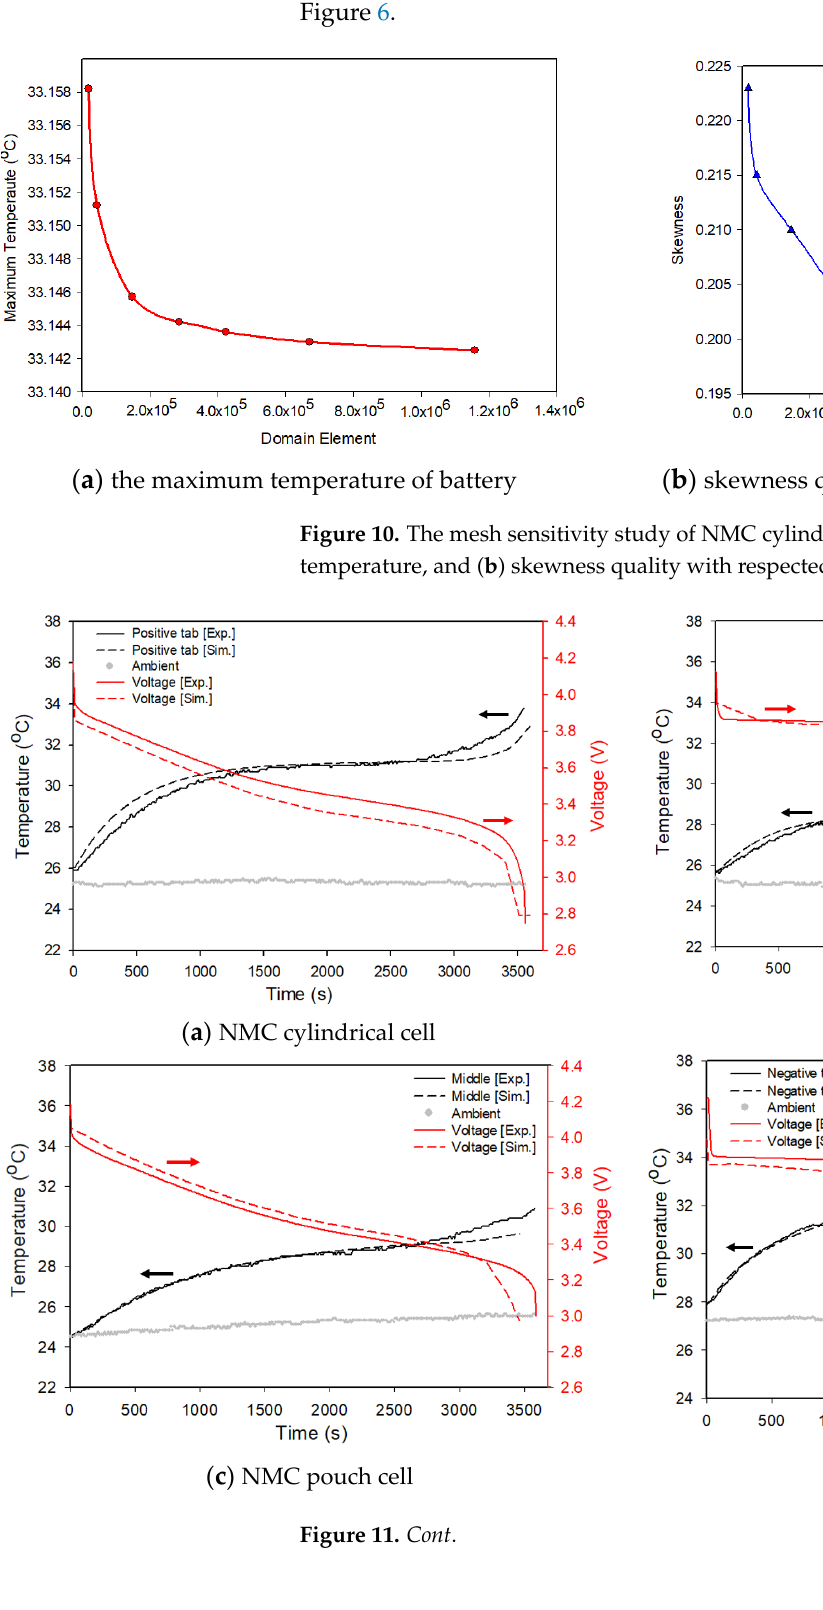
( f ) LFP prismatic cell Figure 11. The validation of simulation with experimental results of the battery surface tempera- ture and cell voltage characteristics: ( a ) NMC cylindrical, ( b ) LFP cylindrical, ( c ) NMC pouch, ( d ) LFP pouch, ( e ) NMC prismatic, and ( f ) LFP prismatic. 4.3.4. Validation of Mathematical Battery Temperature Modeling The mathematical battery temperature equation in Equation (19), which was adopted from the heat balance equation, was implemented to comparatively evaluate the battery temperature with the experiment in this section. The result of entropy change from Section 4.2 was substituted in Equation (19). The numerical and experimental results of battery temperature for all cells are illustrated in Figure 12. The tendency of the battery tempera- ture based on the calculation of the heat balance equation was similar to that of the exper- iment, with gradual difference over time. A large deviation was observed in both NMC and LFP pouch cells because of the limitation on the use of a single-dataset internal re- sistance input. However, this approach still had a restriction on the temperature predic- tion, because it required the entropy change as the input parameter, and it did not con- sider that the temperature affected the internal resistance, resulting in the deviation be- tween the calculation and experimental results.